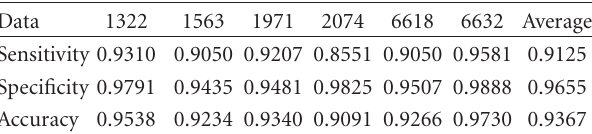
Table 6: The sensitivity, specificity, and accuracy values after Bayes- Gaussian classifier.